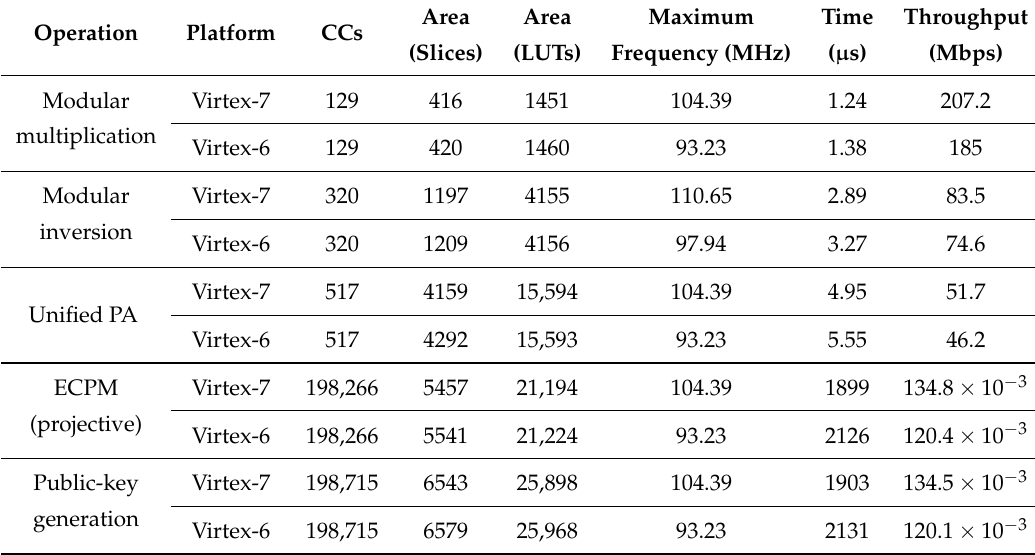
Table 1. Implementation results of the proposed ECC modules on different FPGA platforms over F p